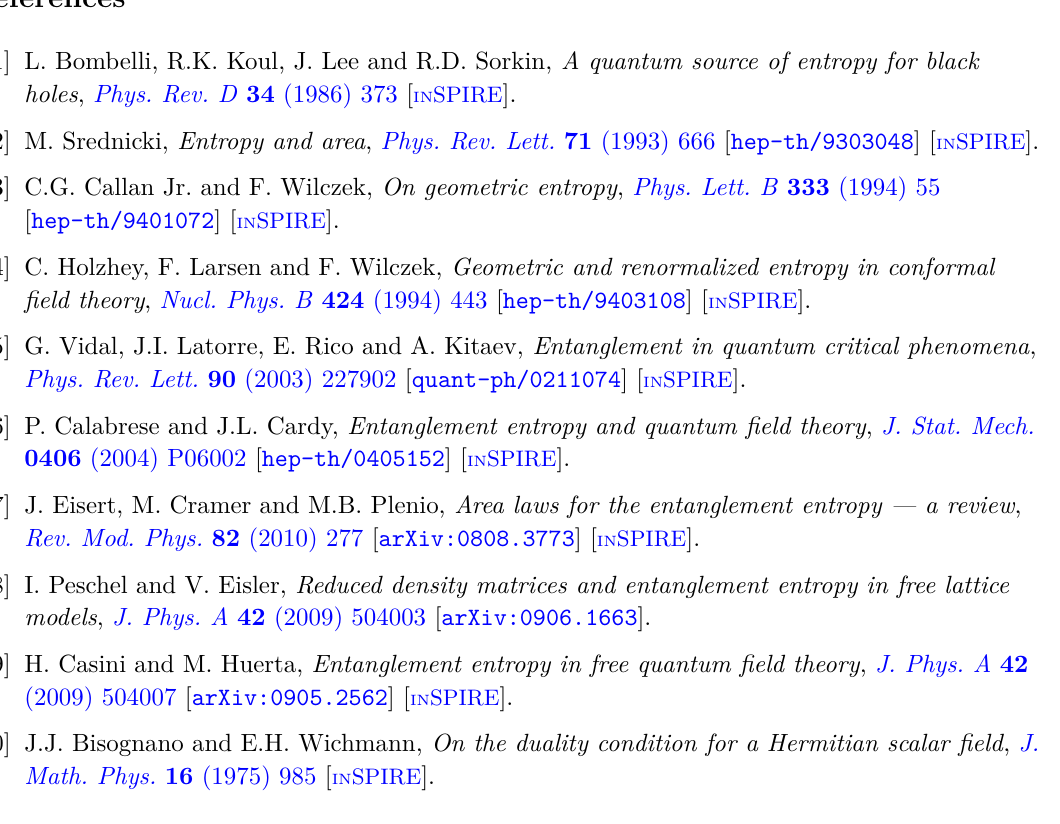
Figure 15. Combination (3.18) when ω = 0 in the case of d = 3 , for different values of k dashed red horizontal lines correspond to µ 3 ( l ) = l ( l + 1) , i.e. (2.11) when d = 3 . These panels should be compared with the right panels of figure